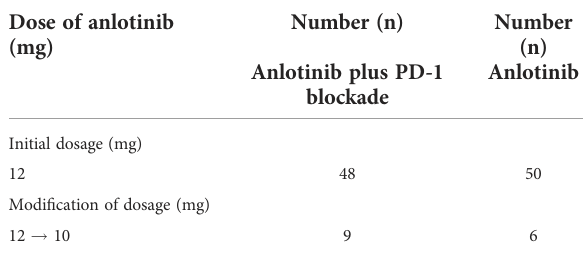
TABLE 4 Treatment administration and dose modi fi cation of anlotinib. Dose of anlotinib